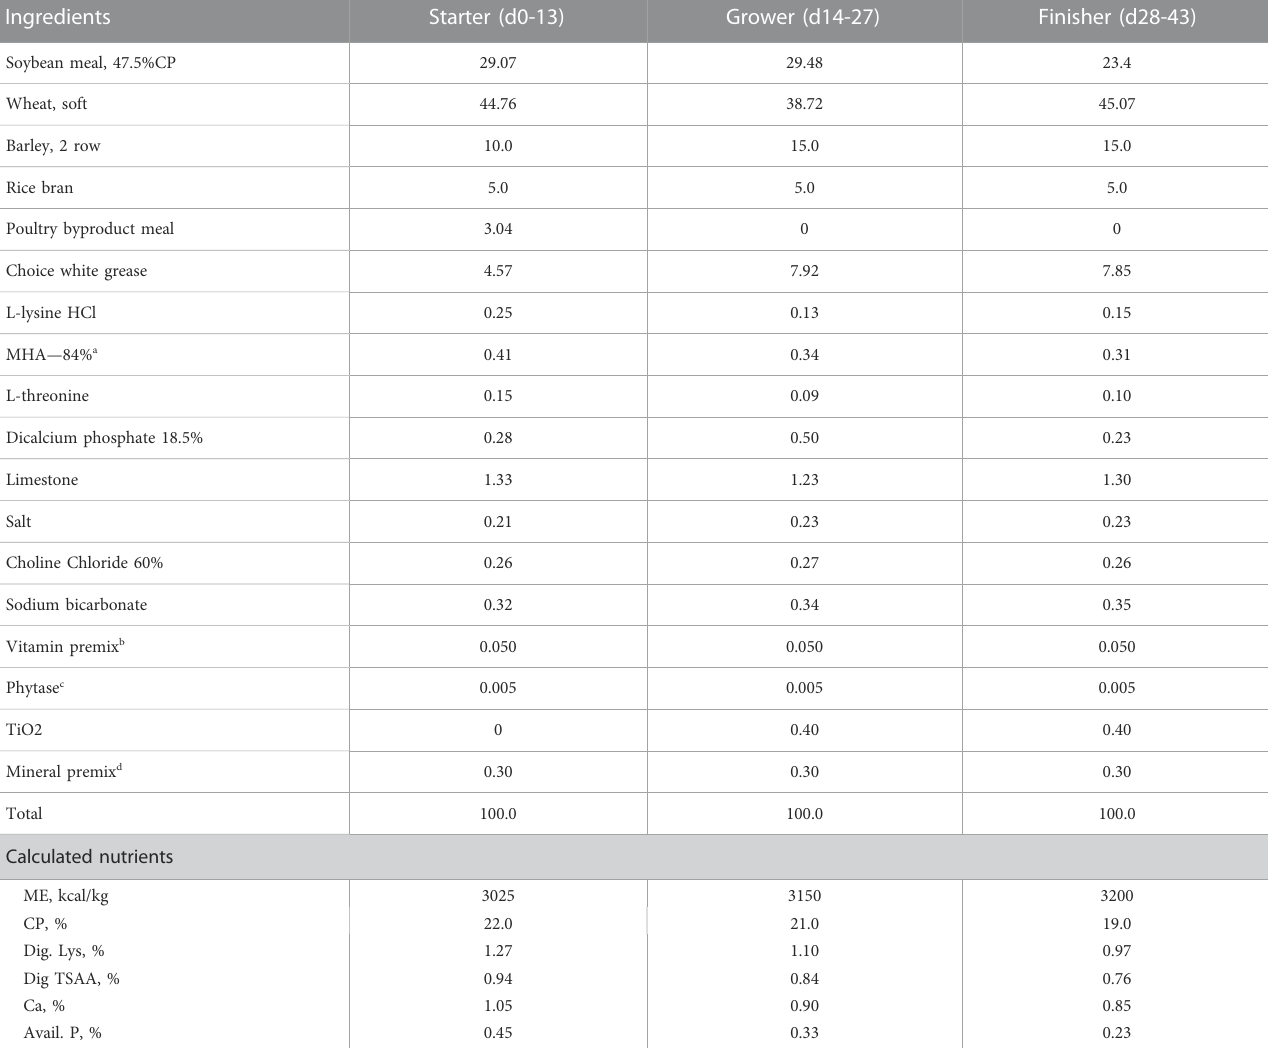
TABLE 2 Composition (%) and calculated nutrient content of basal diets during starter, grower and fi nisher phases in experiment #2.